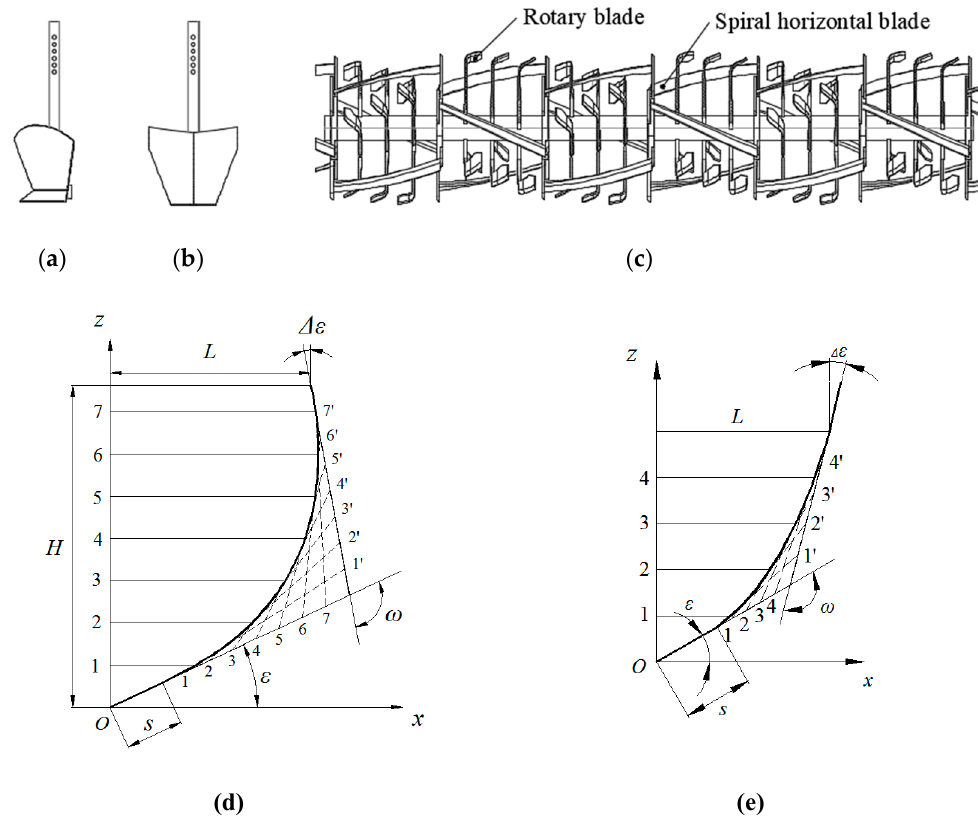
Figure 1. The schematic of the single-side plough, double-side plough and rotary tiller: ( a ) the single-side plough, ( b ) the double-side plough, ( c ) the rotary tiller, ( d ) the guide curve of the single-side plough, and ( e ) the guide curve of the double-side plough.